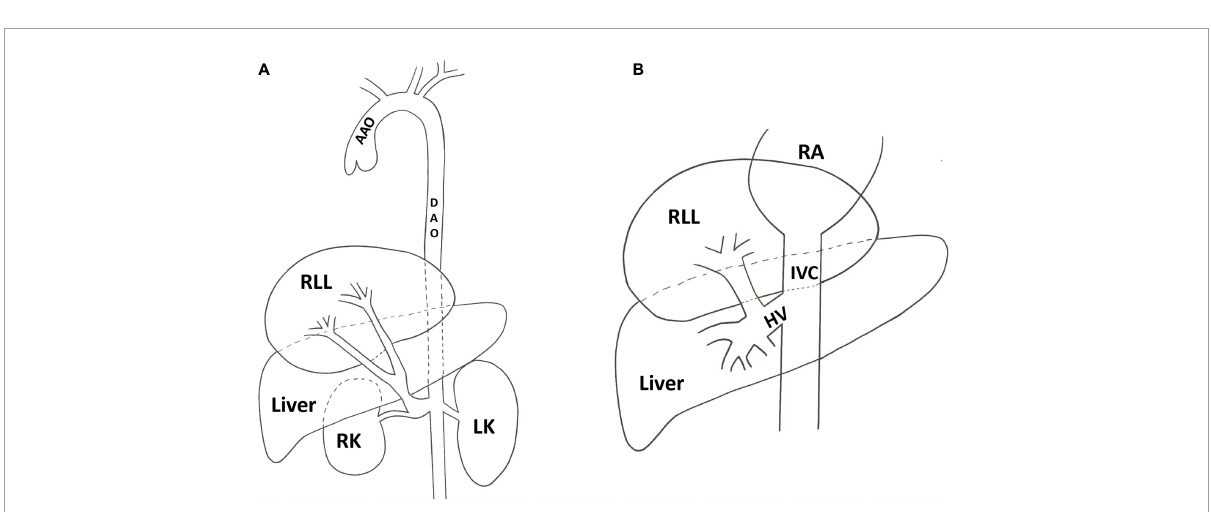
FIGURE4 Schematic figure shows the presented case of pulmonary sequestration: (A) The arterial supply of the sequestration lung arose from a confluent right renal artery. (B) The venous of sequestration lung return to the inferior vena cava via the hepatic vein. AAO, ascending aorta; DAO, decending aorta; HV, hepatic vein; IVC, inferior vena cava; LK, left kidney; RA, right atrium; RK, right kidney; RLL, right lower